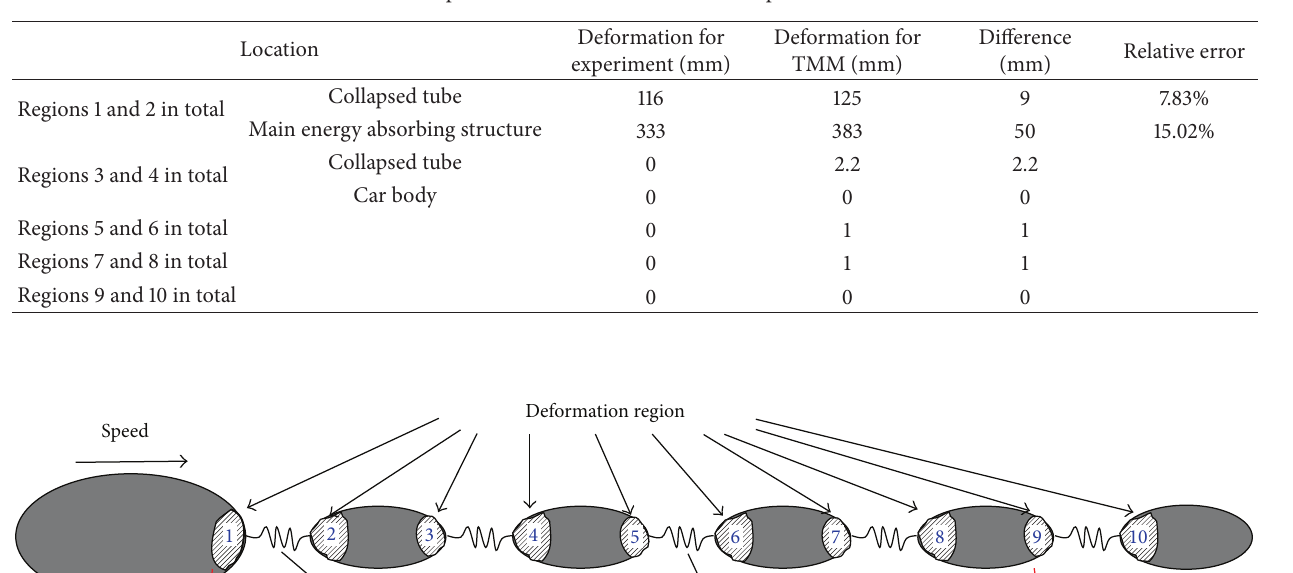
Table 3: Comparison of deformations between experiment and TMM.